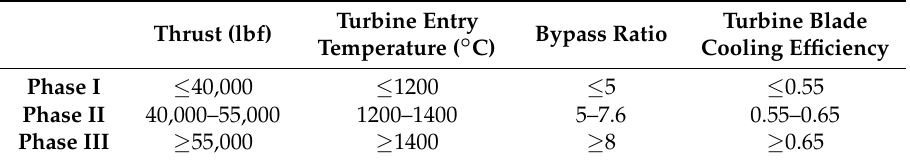
Table 1. Quantitative analysis of different phases